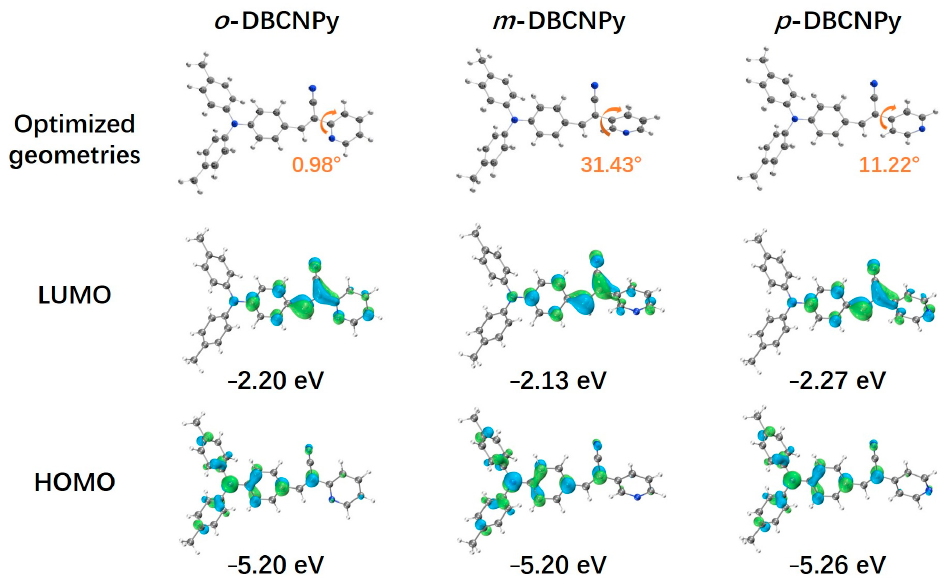
Figure 5. Optimized molecular geometries, electron density distributions, and energy levels of the HOMO and LUMO orbitals for the molecules at the B3LYP/6-311g(d) basis set. Cyclic voltammetry (CV) analysis was carried out and the CV curves of the fl uoro- phores were recorded (Figure 6). The oxidation potential ( E ox ) of the three molecules from